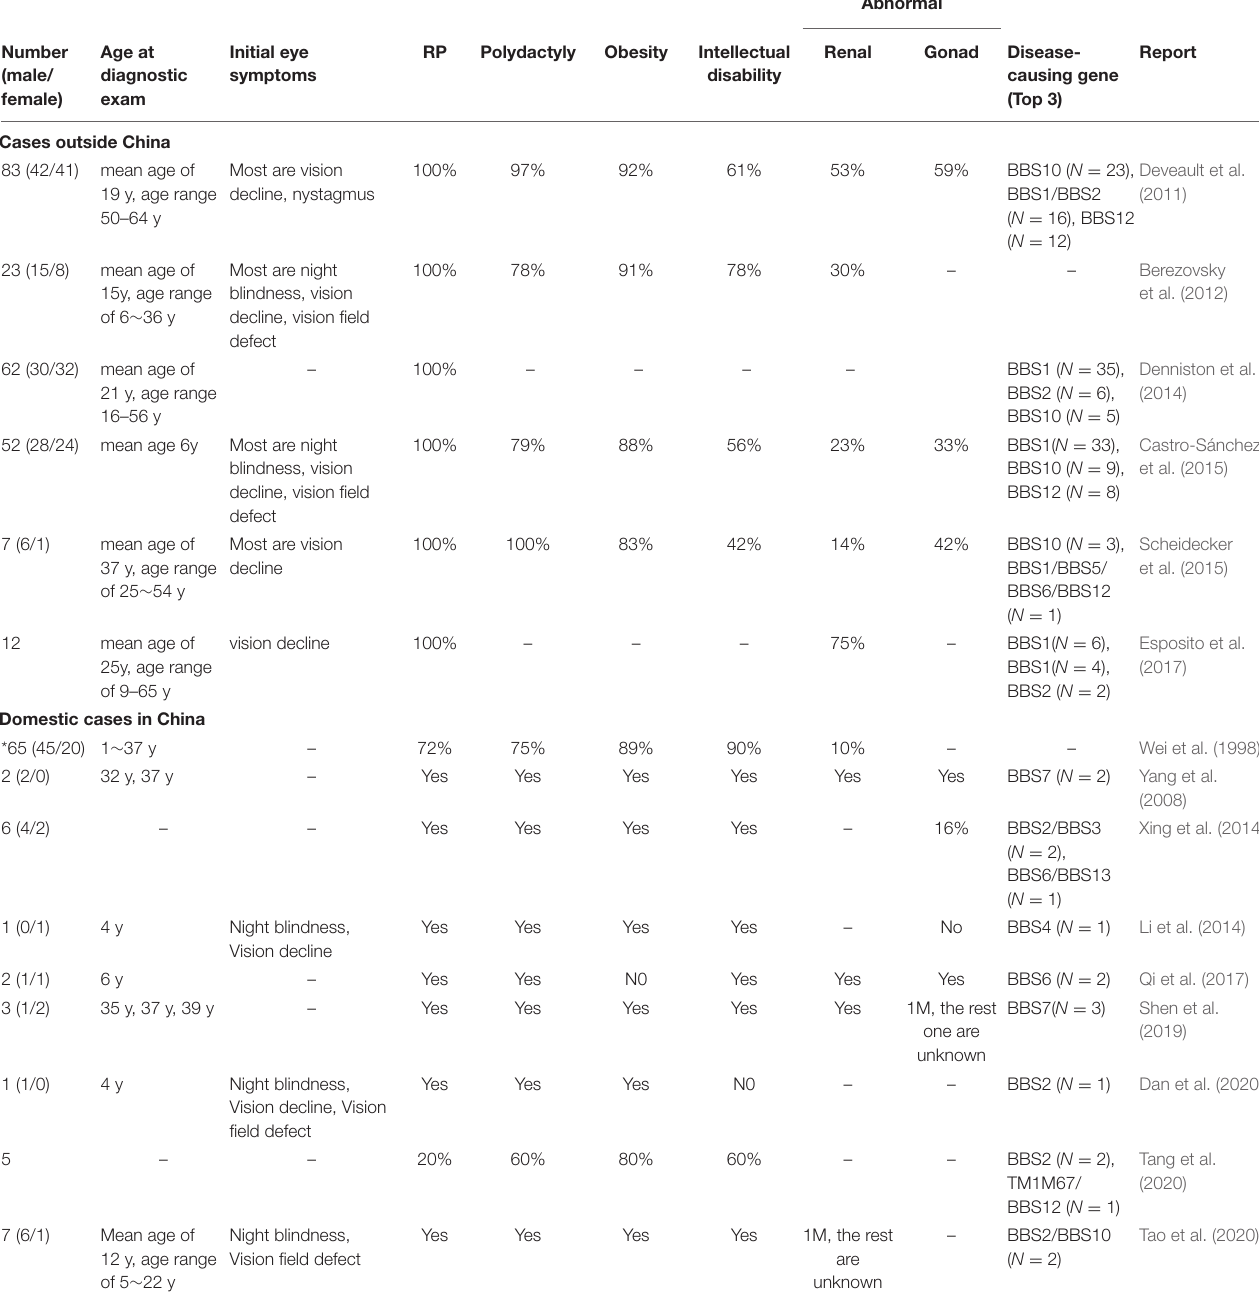
TABLE 4 | Clinical manifestations and disease-causing genes of patients with BBS from previous reports # .